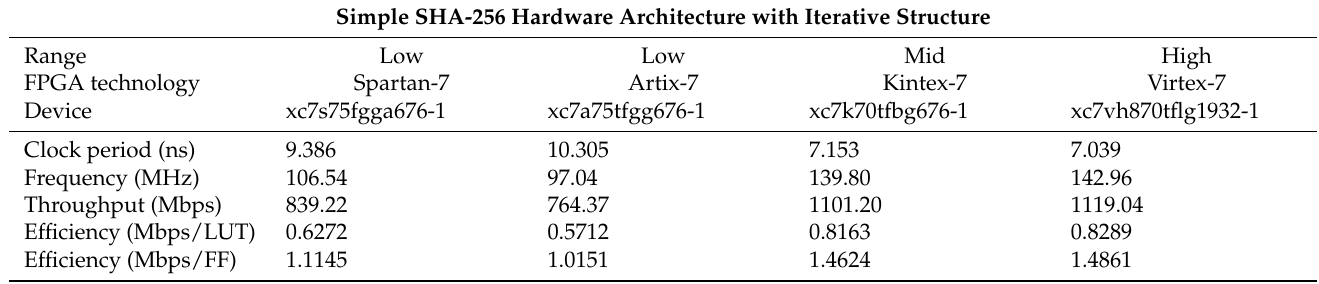
Table 3. Implementation results for the simple SHA-256 hardware architecture with iterative structure.